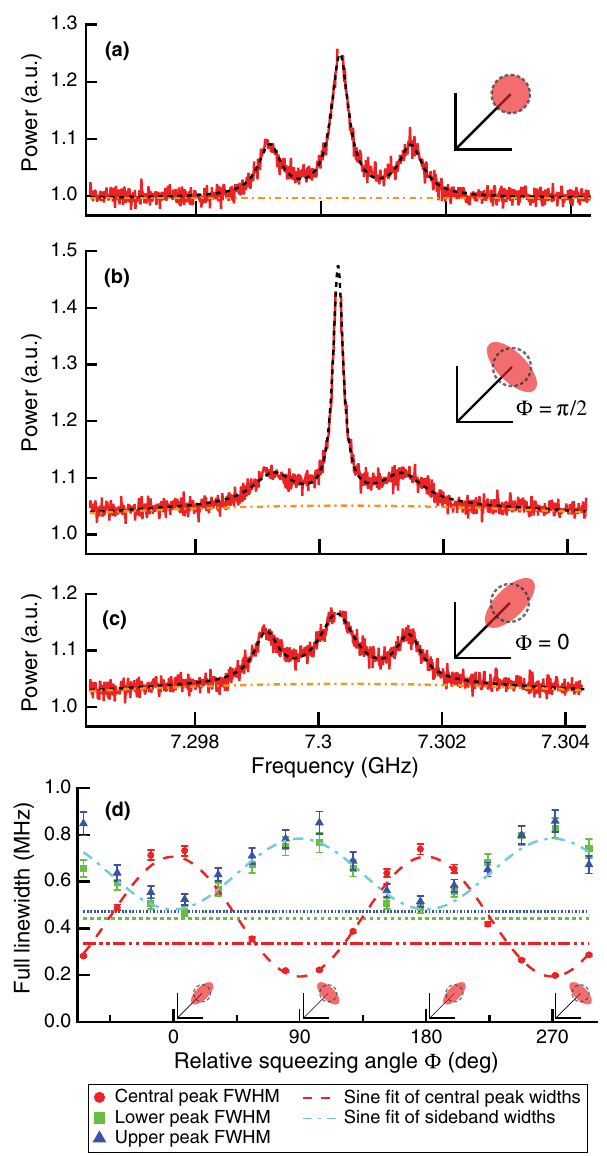
FIG. 3. Reflection spectra for excitation with a coherent drive 1 . 5 dB), and (a) in ordinary vacuum, (b) with Φ ¼ π = 2 ( G JPA ¼ 1 . 5 dB), where Φ þ π = 2 is the phase (c) with Φ ¼ 0 ( G JPA ¼ angle between the coherent drive and the squeezing axis (see Appendix B for definitions). The spectra are normalized to FIG. 4. The squeezing level in the artificial atom ’ s environment account for the JTWPA ’ s gain ripple such that the background as a function of gain G . The quantity M - N determines the level in ordinary vacuum is 1; the parabolic backgrounds (orange JPA minimal quadrature variance of a squeezed state as indicated in dashed line) in (b) and (c) result from the reflected JPA noise the inset. The values of M - N are inferred from measurements of power. (d) The black dashed curves are fit using an approximate the fluorescence spectrum in squeezed vacuum with (red) and three-Lorentzian model; linewidths of this fit are plotted in (d) as without (blue) a coherent Rabi drive. The error bars reflect fit a function of Φ . Error bars reflect fit uncertainties. The two uncertainties. The measurements with no Rabi drive give a more dashed curves are out-of-phase sine functions fit to the central- reliable indication of the squeezing level as they are less sensitive peak and sideband linewidths inferred from measurements in to background effects and experimental drift. The dashed orange squeezed vacuum, while the dashed horizontal lines indicate the curve is a one-parameter fit to the blue data points yielding corresponding linewidths inferred from measurements in ordi- η ¼ 0 . 55 nary vacuum.